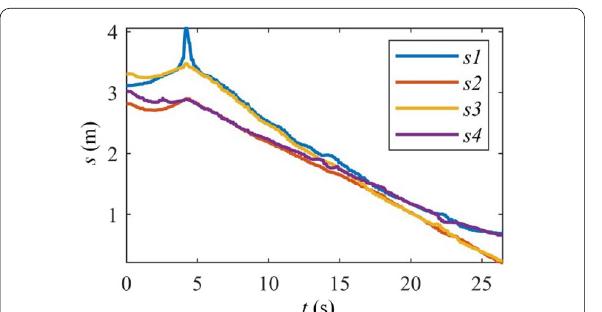
Figure 19 Y ‑direction coordinates